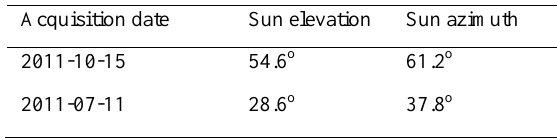
Table 1. Characteristics of TM5 data used for the